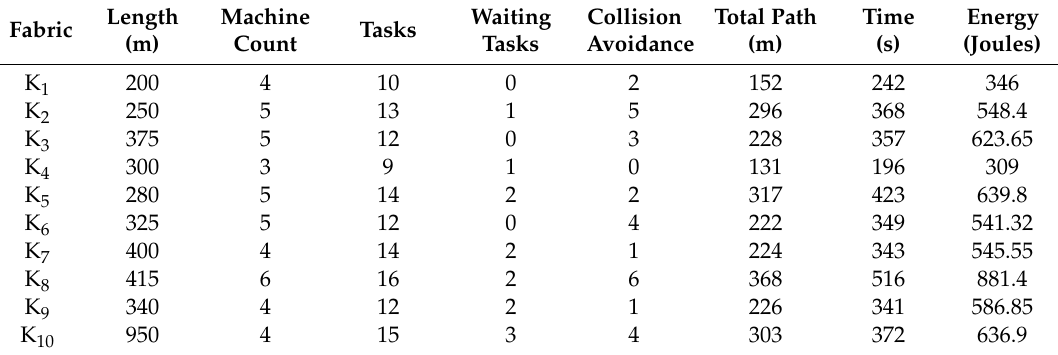
Table 3. Results of the simulation